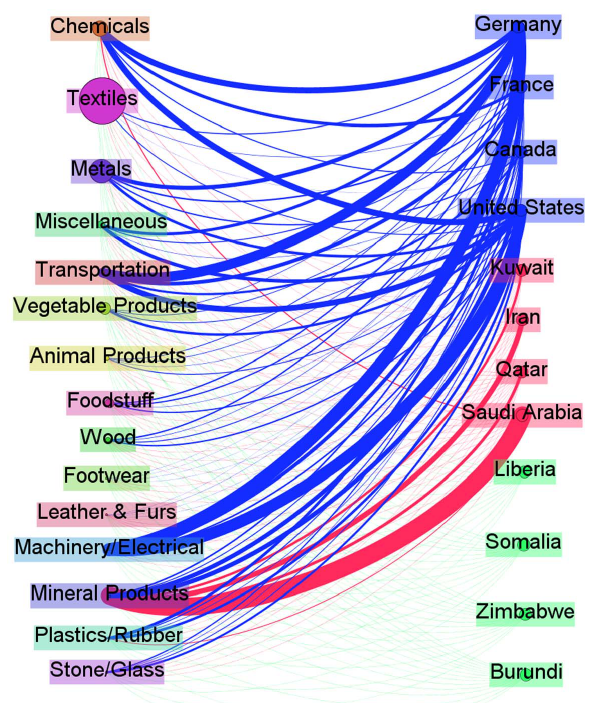
Figure 2. Trade network structure. In this figure we show the weighted bipartite Trade network. On the right the three groups of countries, detected by our algorithm, and on the left the 97 products categories, grouped in 15 homogeneus macro categories in order to highlight the relevant connections among the two different type of nodes. The size of the macro categories are in proportion to the number of categories grouped in them. It is clear from the links partition how our metodology is able to disentangle different country categories according to the trade patterns, even for the third world countries (green background) for which the link weights are much smaller than the others. doi:10.1371/journal.pone.0109507.g002 N First of all, under all the possible scenarios, for M = 100 or M = 250, we always got a 100% percentage of successes in recognizing the clusters correctly. N